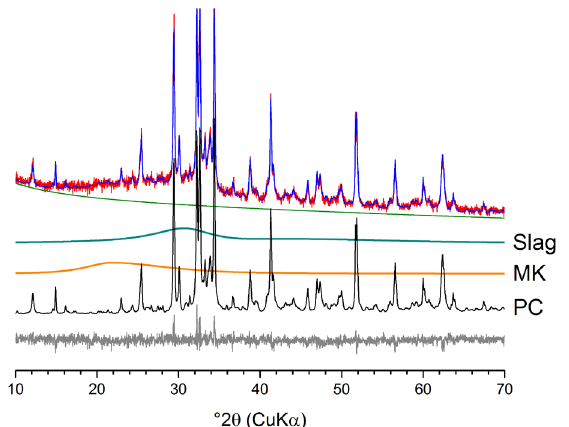
Figure 2. Decomposition of the XRD pattern of a blend of 25% blast furnace slag (Slag), 25% metakaolin (MK) and 50% Portland cement (PC) blend. Quantification of the individual amorphous fractions by the PONKCS